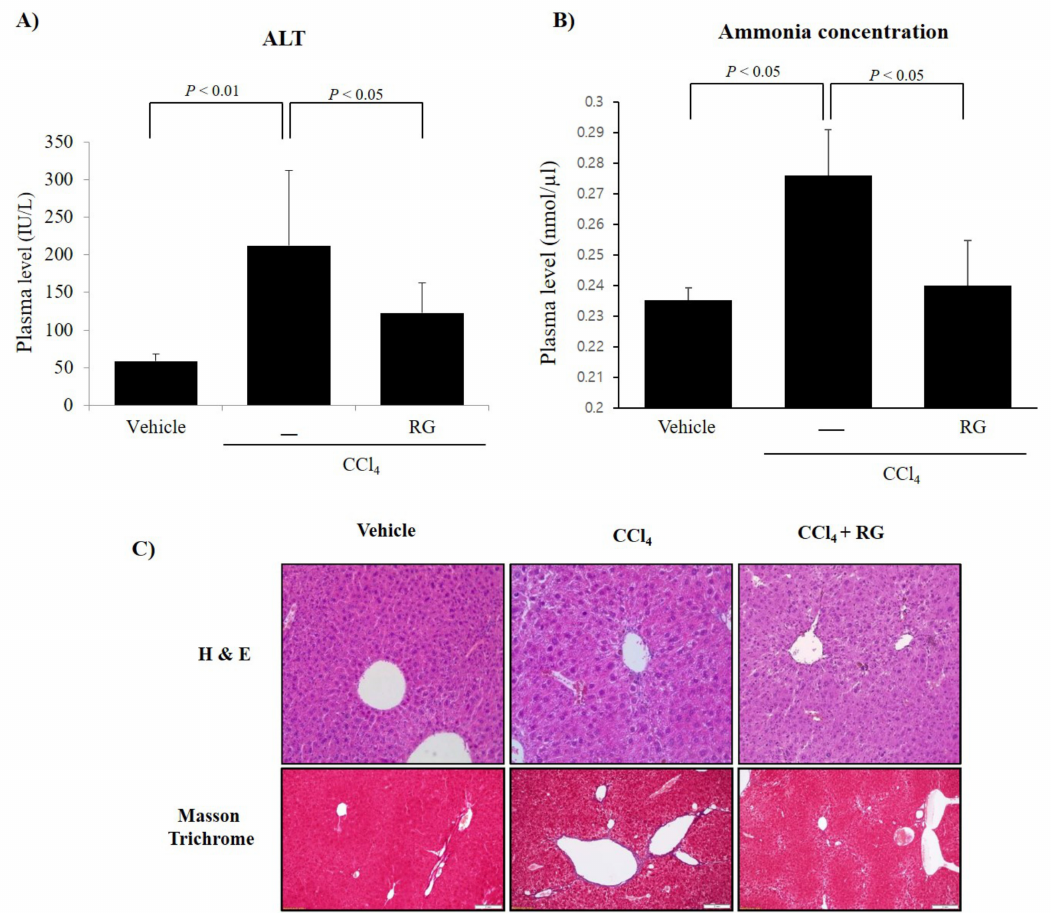
Figure 6. RG protects CCl 4 -induced liver toxicity in mice. Mice were given with repeated injections of CCl 4 (5 mg / kg, 2 times / week, 4 weeks), whereas vehicle mice instead received saline ( n = 4). The CCl 4 + RG group was treated with RG (10 mg / kg of R plus 100 mg / kg of G) with CCl 4 . After four weeks of CCl 4 injection, mice were sacrificed. ( A ) The activities ALT and ( B ) ammonia were assayed by using semi-automated blood chemistry analyzer after 4 weeks of treatment. Data were represented by the mean ± SD. ( C ) Representative photomicrographs of liver sections processed for H&E (upper row) and Masson’s trichrome (lower row) staining with vehicle, CCl 4 , and CCl 4 + RG. Scale bars = 80 µ